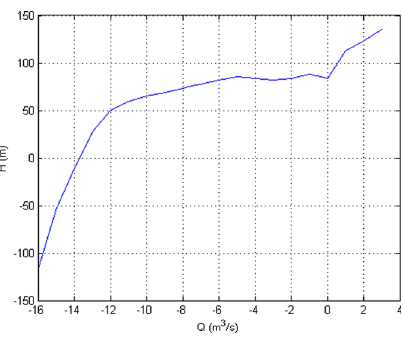
Fig. 3. H – Q pump curve ( (cid:2) 550rpm). Table 2. De fi nition of segments and work areas [6].